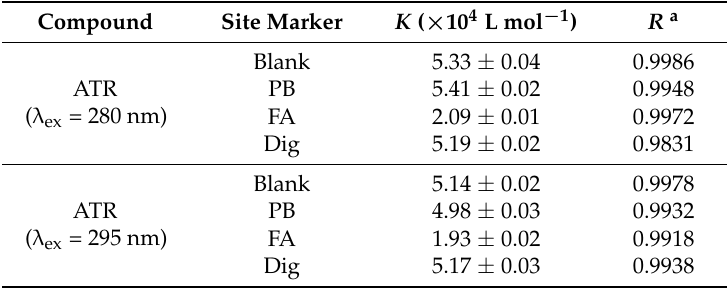
Table 3. Effects of the site probe on the binding constants of ATR to HSA.